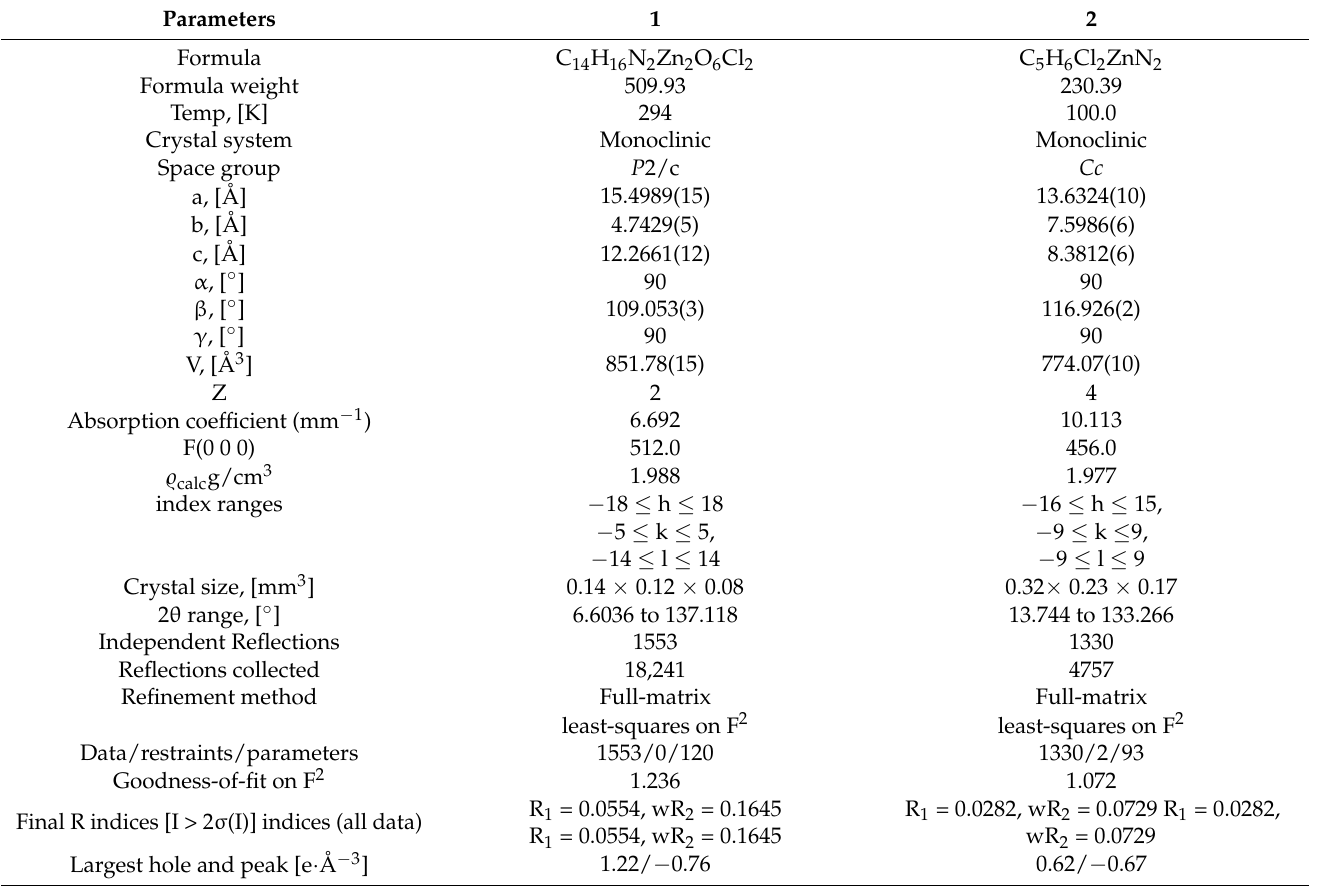
Table 1. Crystallographic data and structure refinement details for compounds 1 and 2